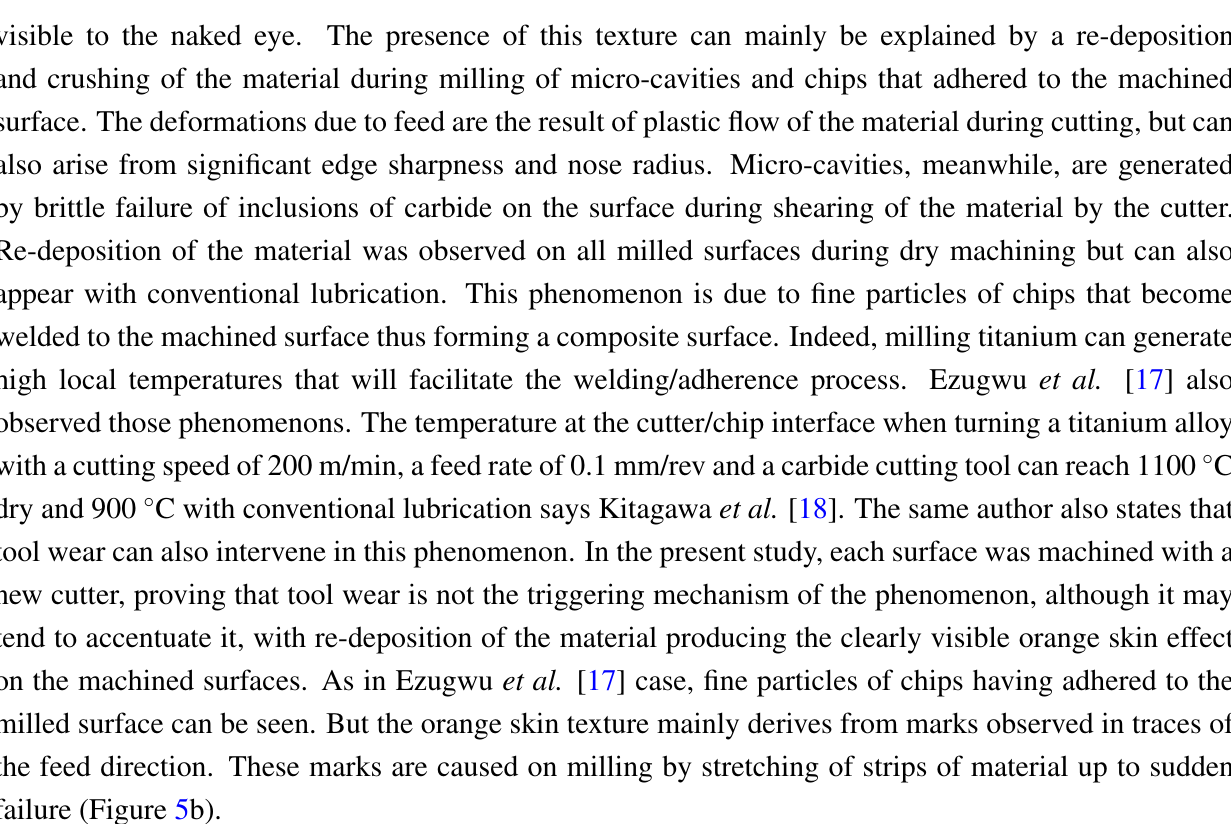
= 0.15 mm; ( b ) Details fin